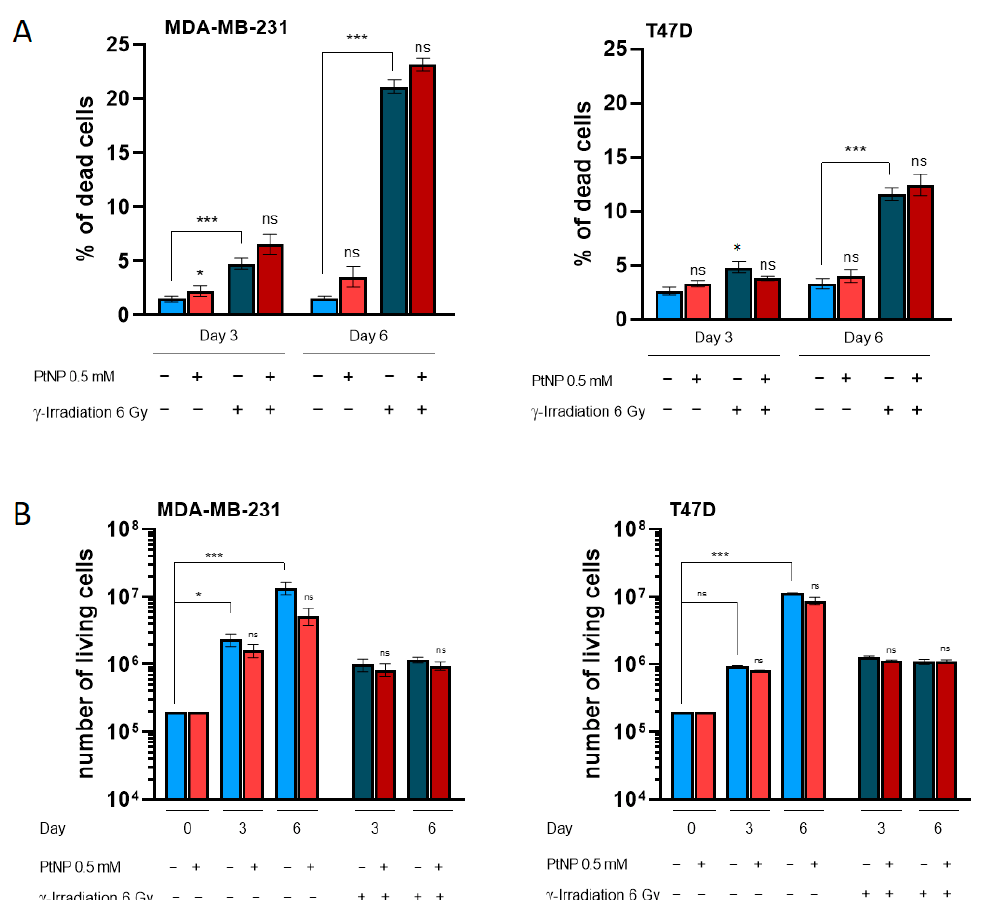
Figure 3. Quantification of cell mortality and survival after the irradiation of cells pretreated with PtNPs or not. ( A ) Percentage of dead cells measured by using the PI exclusion method. Cells were irradiated at 6 Gy after being exposed to 0.5 mM NPs or not, and the mortality was evaluated after 3 or 6 days of culture. The experiment was conducted on two independent sets of triplicates for each time point for the MDA-MB-231 cells and on one triplicate for day 3 and two independent sets of triplicates for day 6 for the T47D cells. ( B ) Measurement of the proliferation by counting the absolute living cell numbers. Cells were irradiated at 6 Gy after being exposed to 0.5 mM NPs or not. Cell counts were assessed by flow cytometry, after 3 or 6 days of culture post-exposure. The experiment was conducted on two independent sets of triplicates for each time point for the MDA-MB-231 cells and on one triplicate for day 3 and two independent sets of triplicates for day 6 for the T47D cells. The statistical significance was determined by using the Kruskal–Wallis test. Note: ns, non-significant; * p < 0.05 and *** p < 0.001.